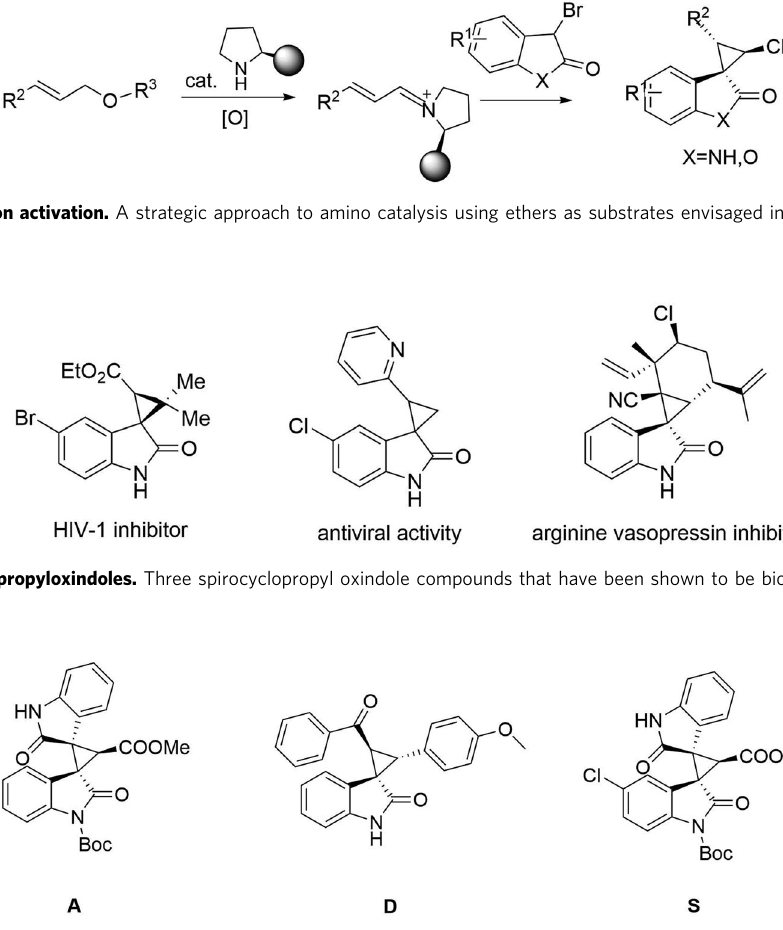
Fig. 3 Related compounds with potential antitumor activity. Three compounds with potential biological activity that can be synthesized by the methods of this